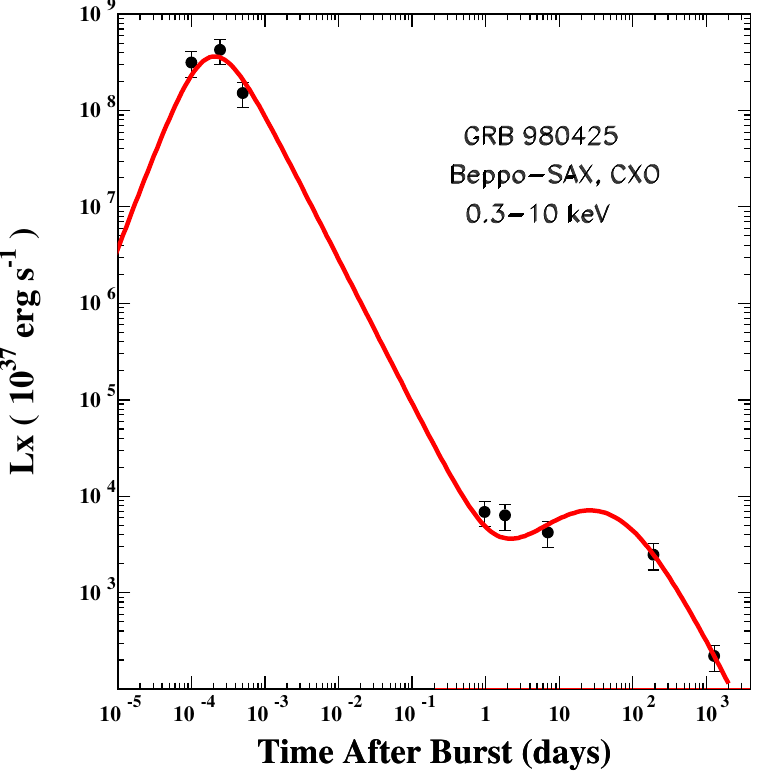
Figure 24. The 0.3–10 keV X-ray light-curve of GRB980425 measured by Beppo-SAX [161] (first 7 points). The last point at 1281 days is due to the source S1b resolved by CXO [132,133]. The line is the CB model best fit light-curve to the prompt emission pulse and the AG of GRB980425, yielding γ θ ≈